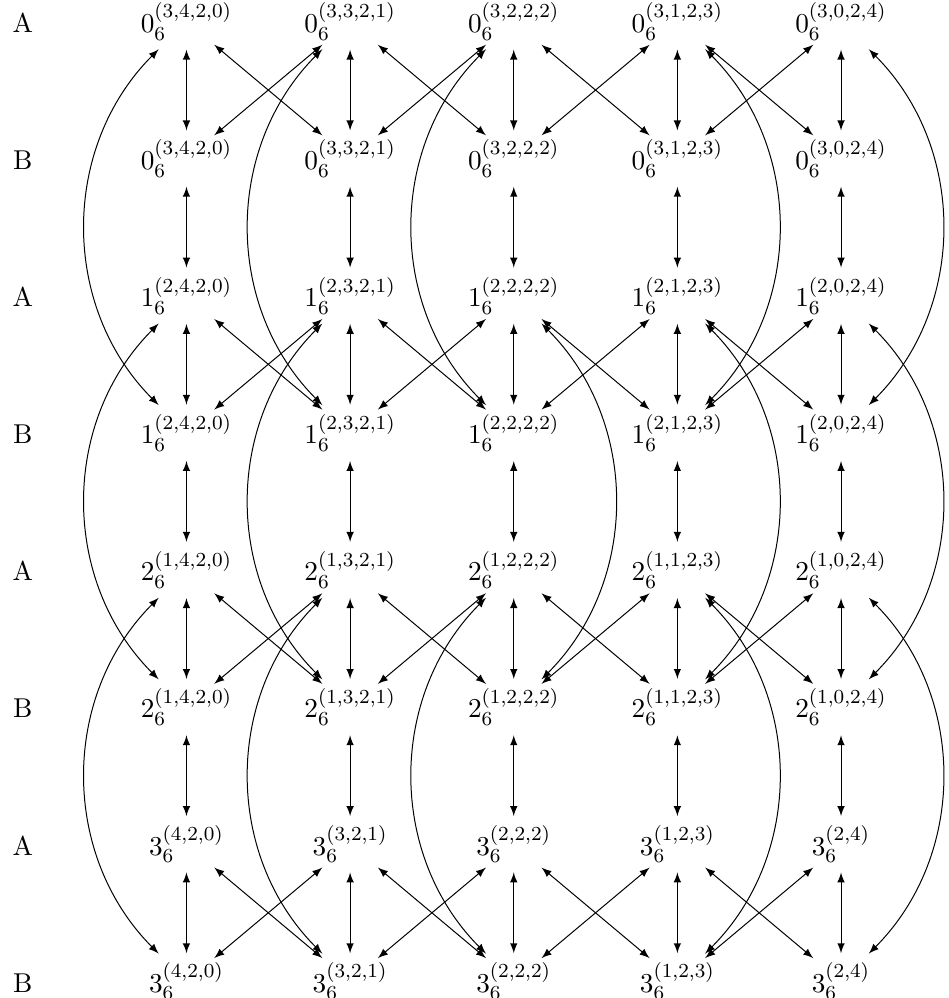
Figure 12 . The T-duality orbit of the 3 (2 ; 4)